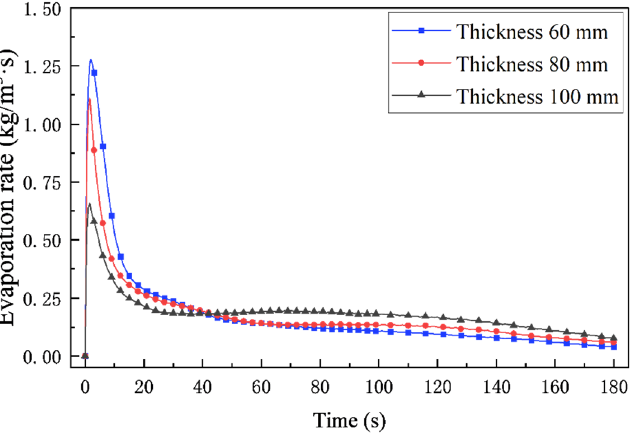
Figure 8. Overall average evaporation rate of the heaped tobacco strips models.